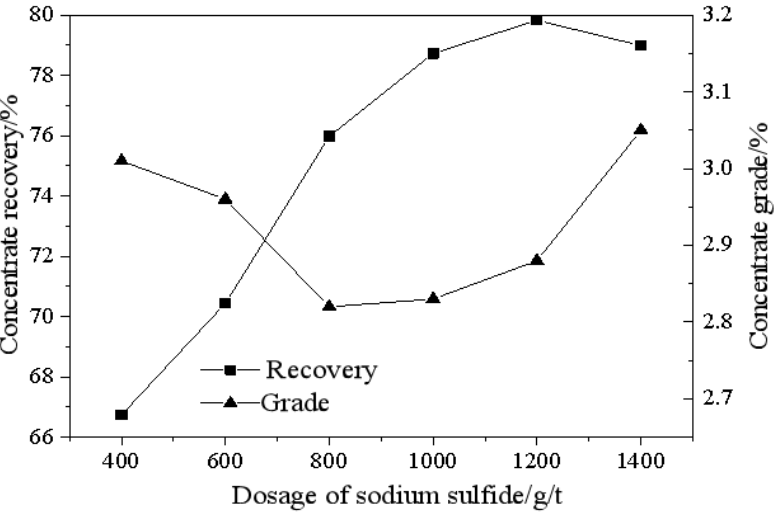
Figure 5. Influences of the sodium sulfide dosage of the copper oxide flotation index.